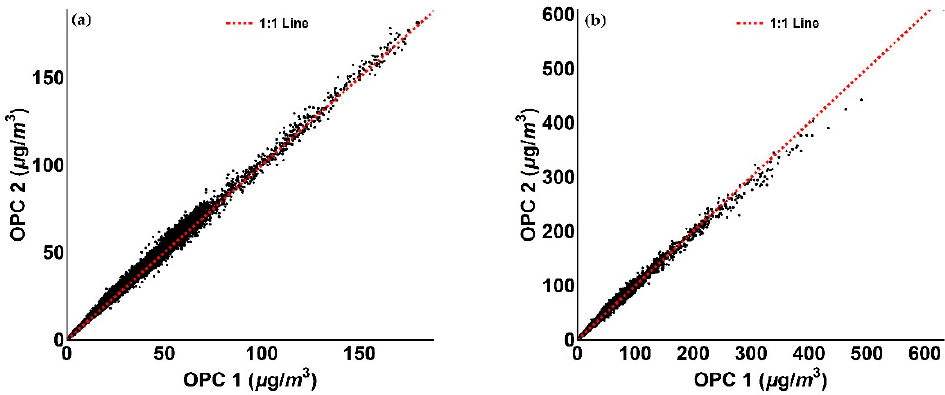
Table 4. Correlation values for Alphasense OPC-N2 sensors used during this study. Figure 8. Figures illustrating the reproducibility of the two Alphasense OPC-N2. ( a ) Scatter plot of OPC 1 and OPC 2 PM 1 measurement relative to the period between 17 December 2017 and 16 January 2018; ( b ) OPC 1 and OPC 2 PM 2.5 measurement scatter plot of OPC 1 and OPC 2 PM 1 measurement relative to the period between 17 December 2017 and 16 January 2018. Time series of OPC data in comparison with the reference measurements, before and after the application of the correction algorithm, are shown for PM 1 and PM 2.5 in Figures 9 and 10 respectively.